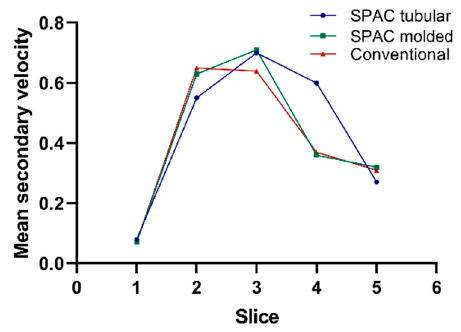
Figure 10. The mean secondary velocity of all three cases on five slices at t 4 .